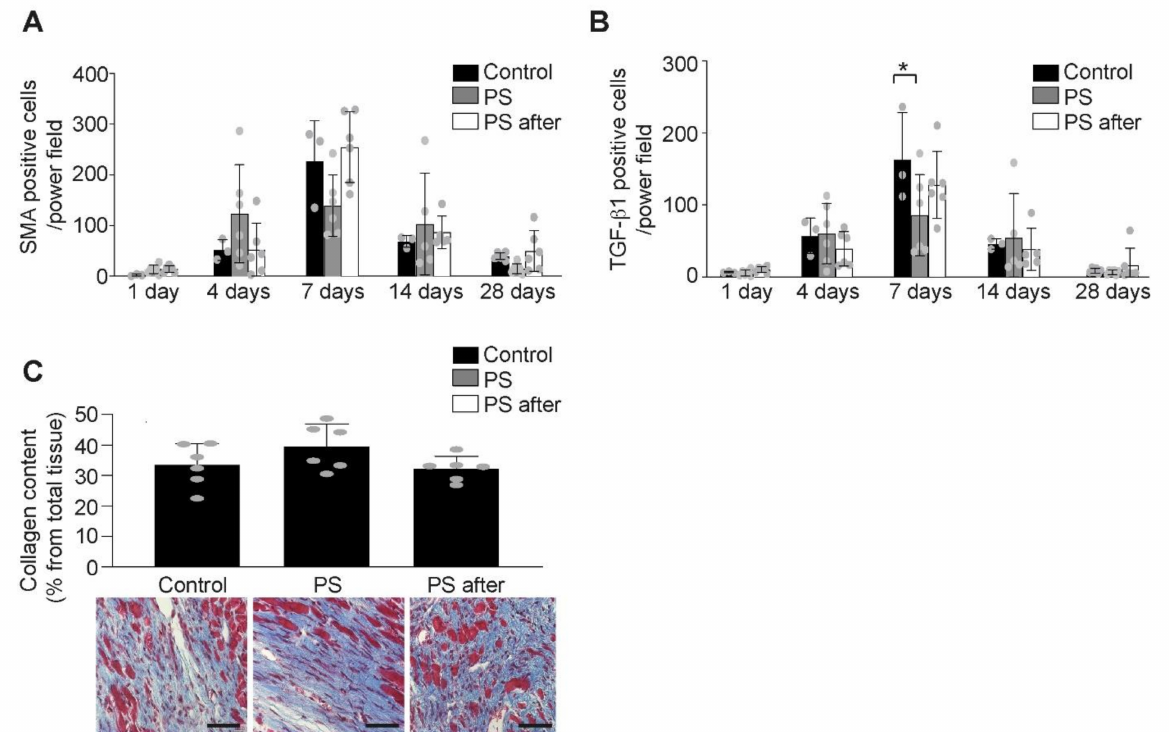
Figure 5. The effect of phosphatidylserine on remodeling after AMI. ( A ) The number of myofibroblasts ( α -SMA positive cells) in the infarct area increased following permanent coronary ligation with no difference between the control or PS treated groups ( n = 5–6/group, Two-way ANOVA, Bonferroni’s multiple comparison Test, Values ± SD). ( B ) TGF- β 1 expression is less pronounced after phosphatidylserine treatment ( n = 5–6/group, Two-way ANOVA, Bonferroni’s multiple comparison Test, * p < 0.05 vs. Control, Values ± SD). ( C ) There was no difference in myocardial collagen content (blue, Gomori staining) expressed as % from infarcted area at 28 days after AMI between control (Control) and phosphatidylserine-treated mice (PS, PS after) ( n = 5–6/group, One-way ANOVA, Turkey’s multiple comparison Test, Values ± SD). Representative images of Gomori staining (lower panel, scale bar 50 µ